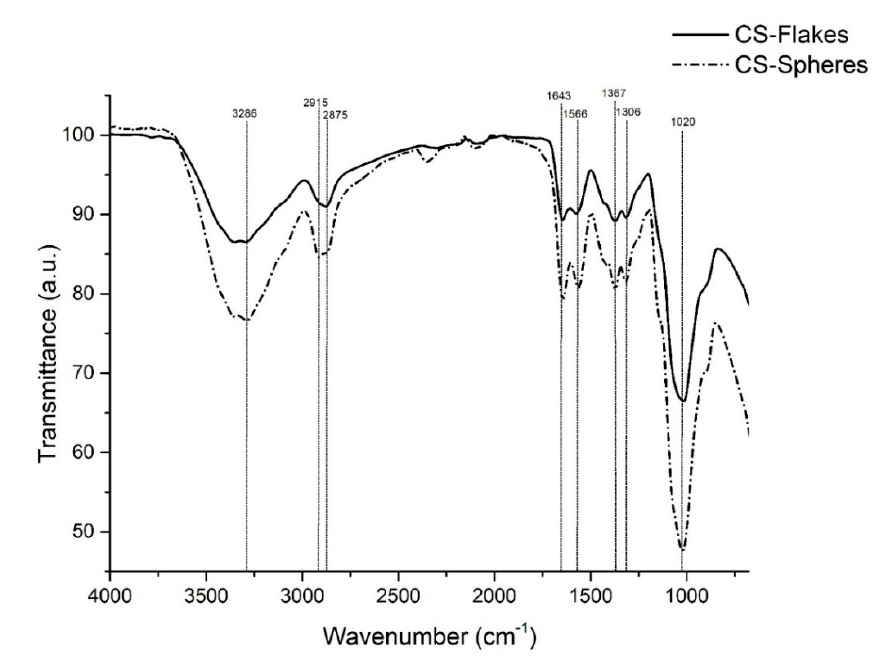
Figure 6. FTIR spectra of CS flakes and CS spheres.